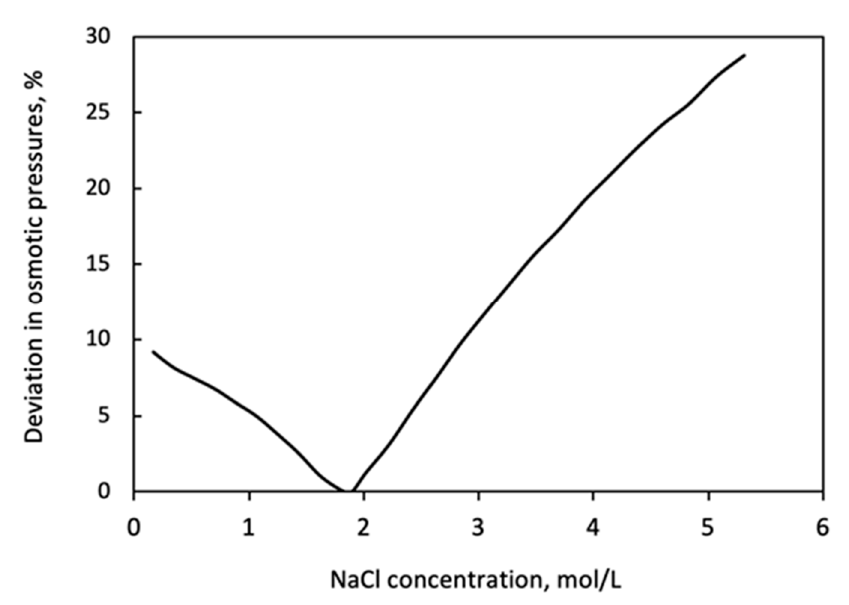
Figure 5. Change of the relative error in percent ( | π lin − π OLI | / π x , where π x indicates the higher pressure in each case) as a function of the solute concentration, applying for prediction of the π value by the van ’t Hoff linear approach and the OLI software.